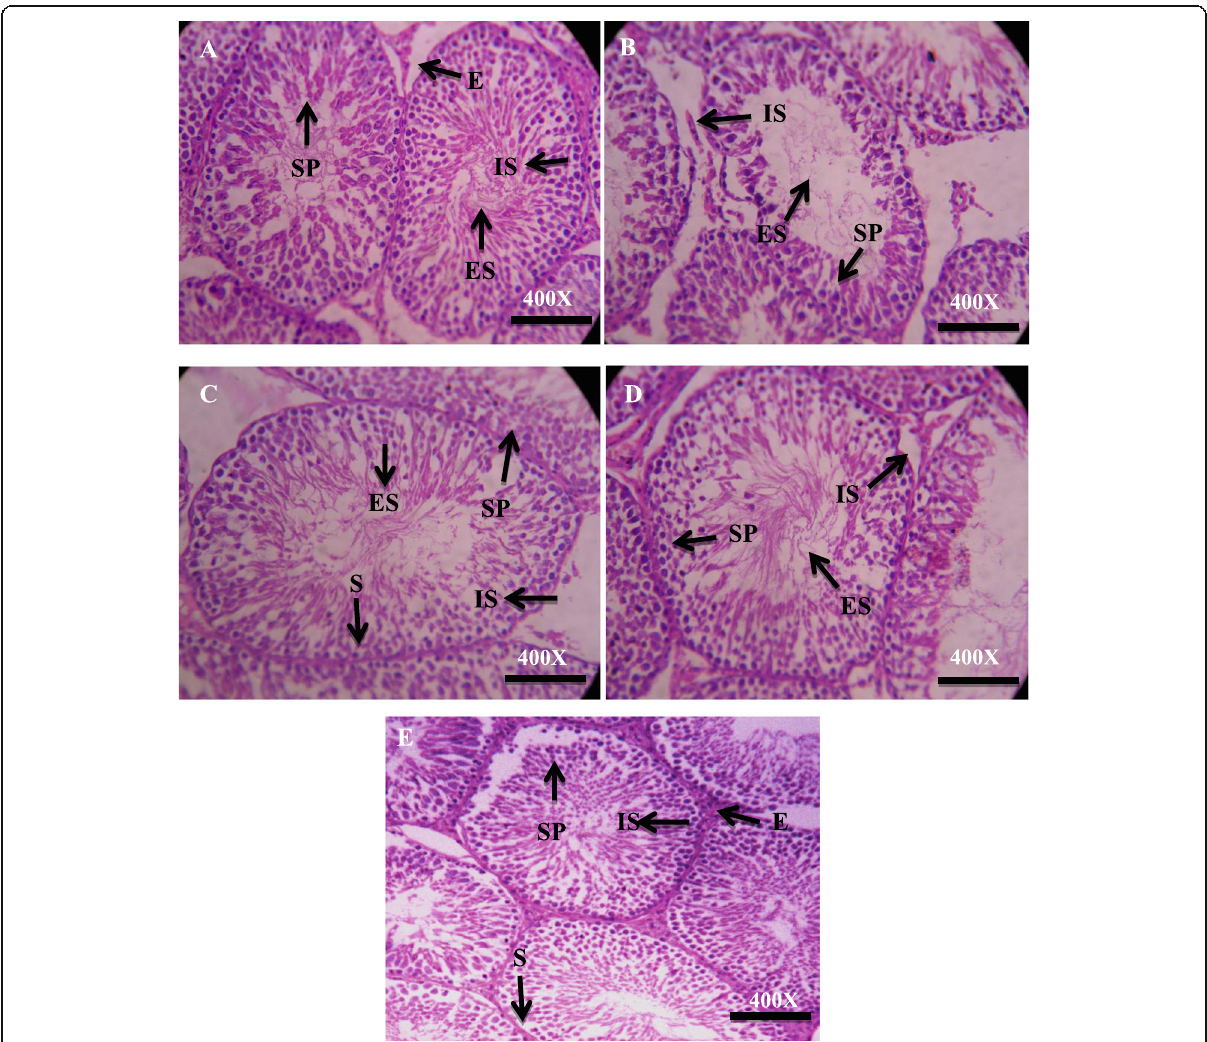
Fig. 4 Photomicrograph of adult male cauda epididymis (H&E, × 40) from control group showing normal morphology of cauda epididymis, thin pseudostratified epithelium lined with stereocilia, and lumen filled with spermatozoa ( a ), Mercury-treated showing reduced pseudostratified epithelium with distorted spermatozoa and empty lumen in most of tubules ( b ), Mercury + vitamin C shows increased spermatozoa and pseudostratified epithelium ( c ), Mercury + C. album shows normal spermatozoa and epithelium ( d ). St, stroma; E, epithelium; S, spermatozoa; × 40 by × 10 = ×